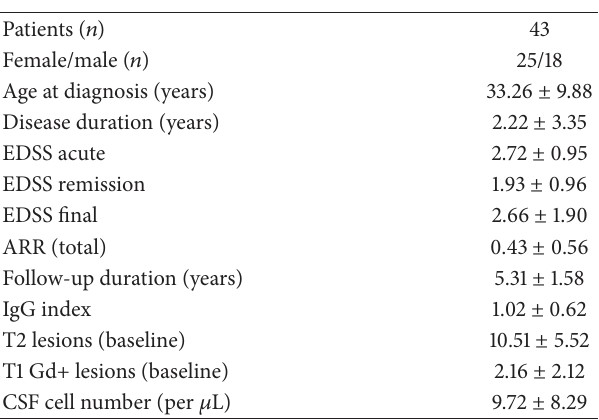
Table 2: Data of study